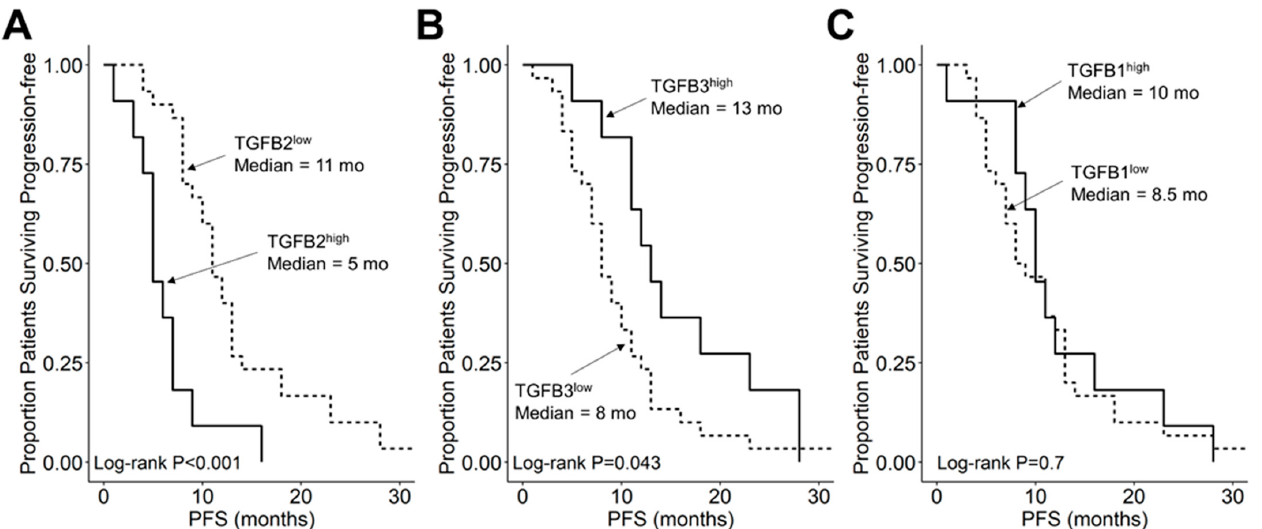
Figure 5. Amplified expression of TGFB2 is associated with shorter PFS in DIPG and DMG patients. Archived clinical outcome data for 41 DMG patients, including 11 DIPG patients with an unknown H3K27M mutational status, 4 H3K27M-mutant DIPG patients and 26 H3K27M-mutant DMG patients, whose brain tumors were localized to brainstem/pons, obtained from cBioPortal for Cancer Genomics (https://pedcbioportal.kidsfirstdrc.org/) was combined with RNAseq-based mRNA expression data for TGFB2 ( A ), TGFB3 ( B ), and TGFB1 ( C ) to assess the potential impact of the respective TGFB isoform levels on PFS. For patients with missing information regarding progression of disease, death was used as the first event when evaluating the PFS outcome. Log 2 -transformed, TPM-normalized RNAseq values were rank-ordered according to expression level for each TGFB isoform. Patients whose expression levels for a given TGFB isoform was greater than or equal to the upper quartile (solid line) were compared to the remaining patients (dashed line). ( A ) TGFB2 high patients with exhibited a significantly worse PFS outcome than rest of the patients (median PFS for TGFB2 high subset: 5 (95% CI: 5–NA) months, 11 events, N = 11); median PFS for TGFB2 low subset = 11 months, 95% CI: 10–13 months, 30 events, N = 30; log-rank chi-square = 14.7, p = 1.3 × 10 − 4 ). ( B ) TGFB3 high patients (median PFS = 13 months, 95% CI: 11–NA months, 11 events, N = 11) exhibited a significantly better PFS outcome than TGFB3 low patients (median PFS = 8 months, 95% CI: 7–11 months, 30 events, N = 30; log-rank chi-square = 4.1, P = 0.043). (C) TGFB1 high patients (median PFS = 10 months, 95% CI: 9–NA months, 11 events, N = 11) and TGFB1 low patients exhibited similar OS outcomes (median PFS = 8.5 months, 95% CI: 7–13 months, 30 events, N = 30; log-rank chi-square =